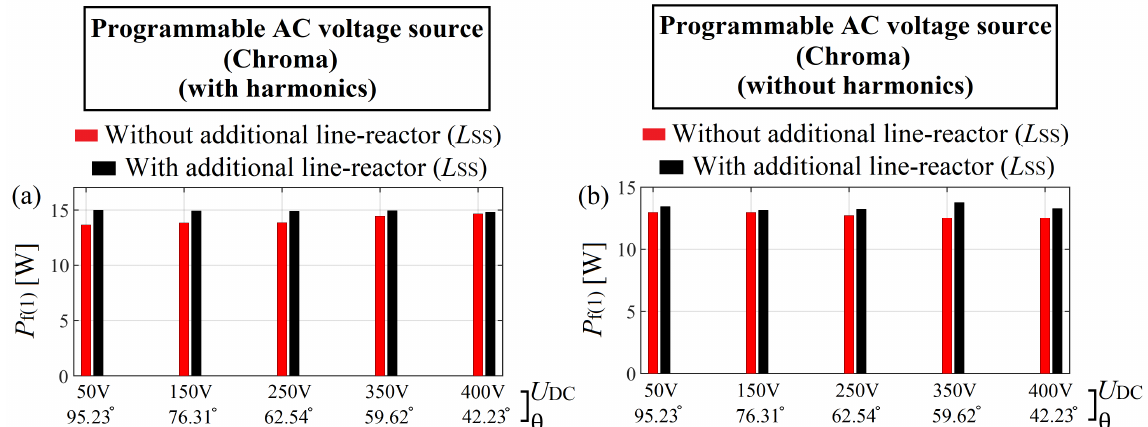
Figure 38. Comparison between the filter power losses (the fundamental harmonic) when the addi- tional line reactor L SS is connected and when it is not connected: Chroma voltage source with ( a ) and without ( b ) harmonics.